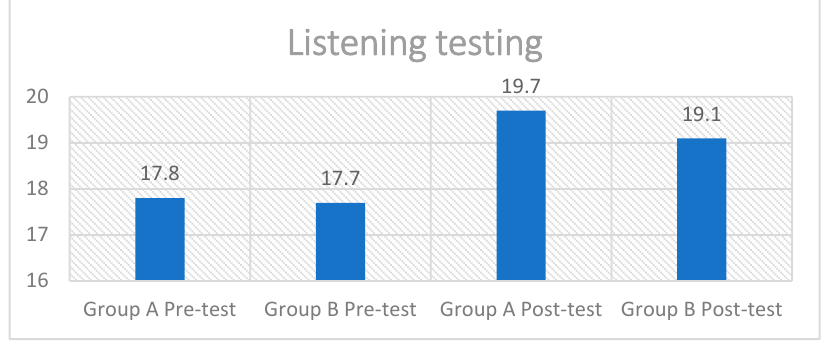
Figure 1. Listening testing results.